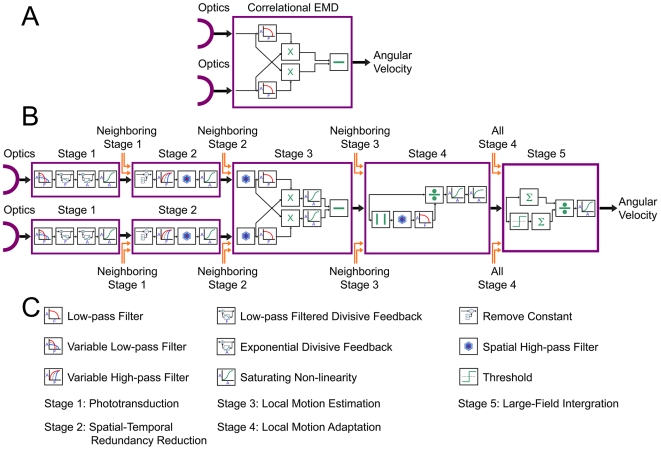
Motion processing model.A) Schematic of a basic correlator elementary motion detector (EMD) used as the fundamental motion detection algorithm in this paper. B) Diagrammatic representation of the fully elaborated motion processing model used in this study. C) Legend describing the symbolic representations used in B). Each stage of the model represents the processing occurring on a pixel-wise basis within the insect visual system. Connections between near-by processing columns (nearest or next-nearest neighbors) in the 2D network occur between stages, mostly in the form of spatial high-pass filtering, with the only global stage a final spatial summation at the start of stage 5. Each stage is further divided into smaller processing steps involving operations such as 1st order low-pass filtering, centre-surround antagonism, non-linear gains or divisive feedback. Further detail is presented in the text.